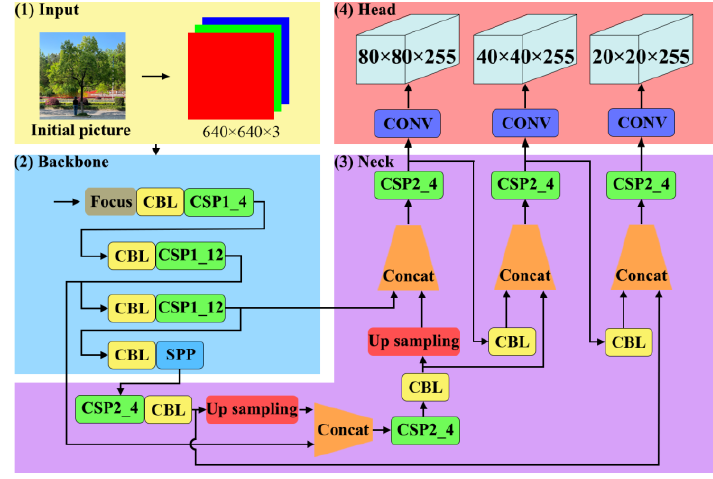
Figure 4. YOLOv5x network structure.